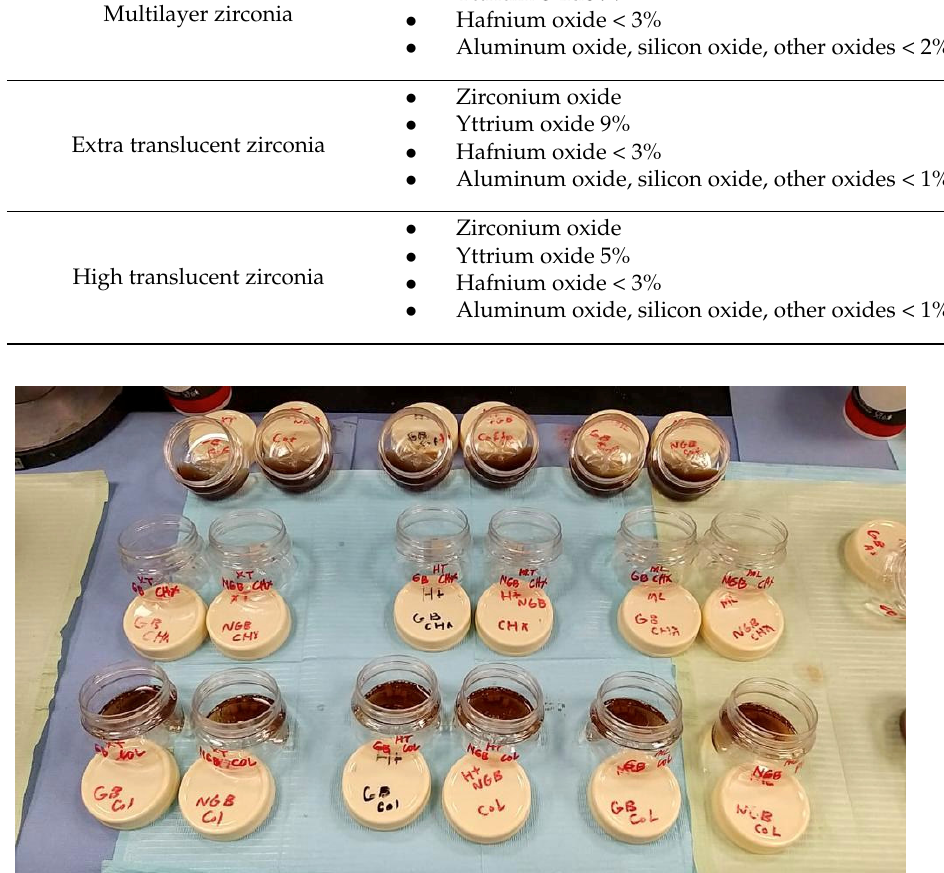
Figure 1. Showing preparation of colored beverages used in this study to immerse and analyze color stability of zirconia samples.